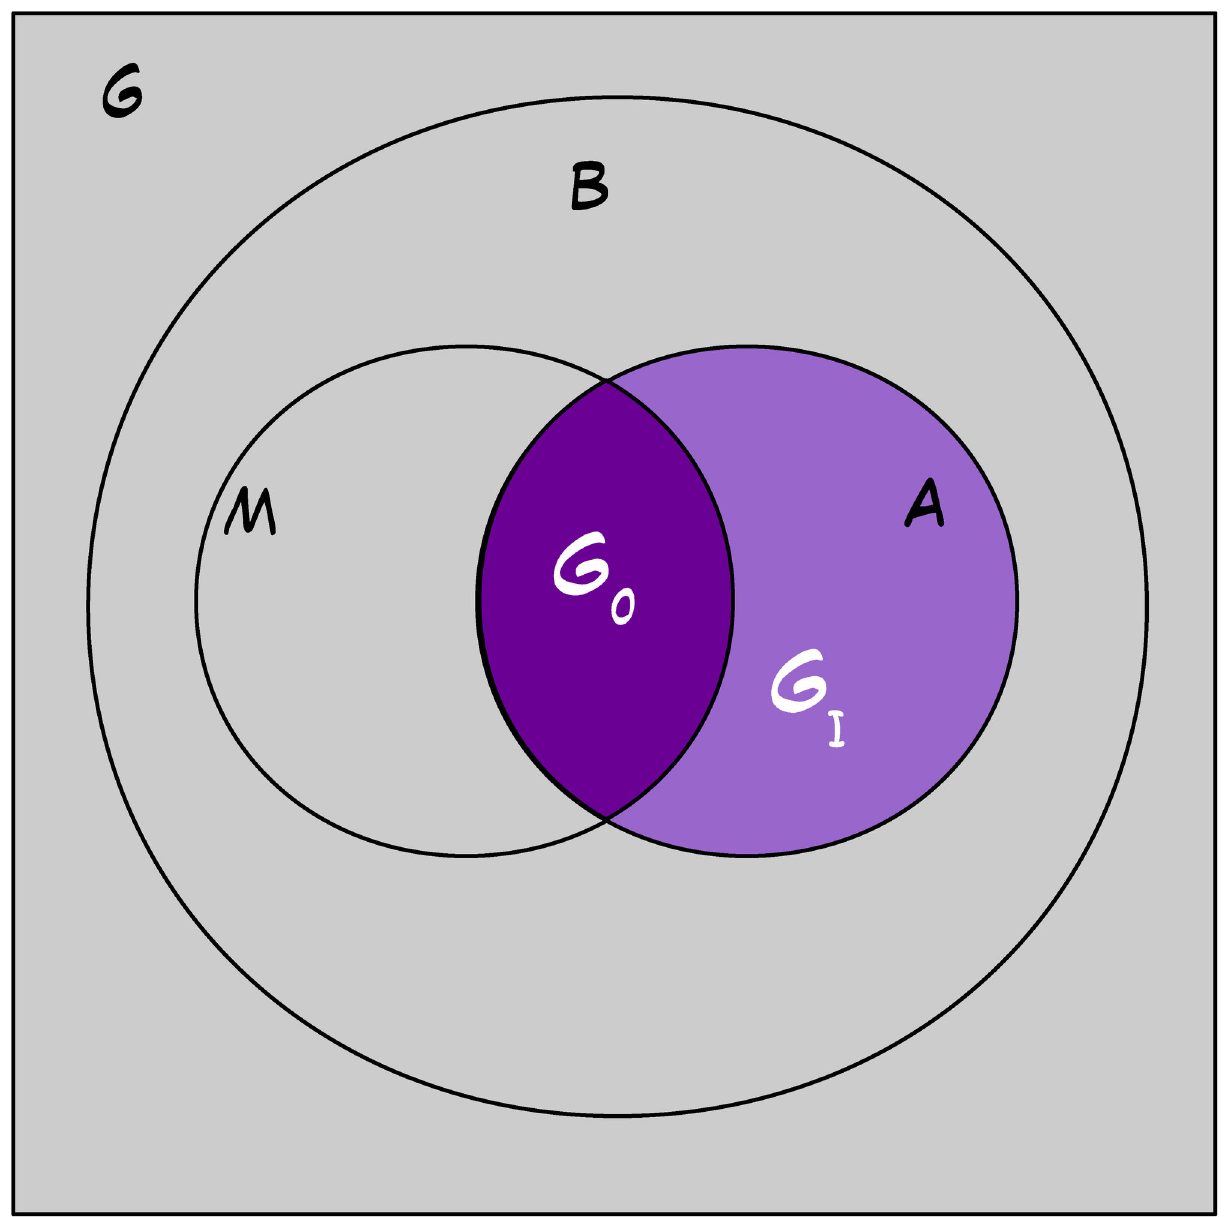
Figure 1. BAM diagram. Simplified version of the Biotic-Abiotic-Movement diagram from Sauge et al. [16]. “G” represents the geographic space. “B” is the part of G that presents the correct set of biotic conditions: in this simplified version B is assumed not to constrain species distribution [3,16]. “A” is the part of G that holds suitable abiotic conditions. “M” represents the sub-area of G that has been accessible and explored by the species. The intersection between M and A defines the species distribution (G area that is potentially suitable, but has not been accessible to the species.